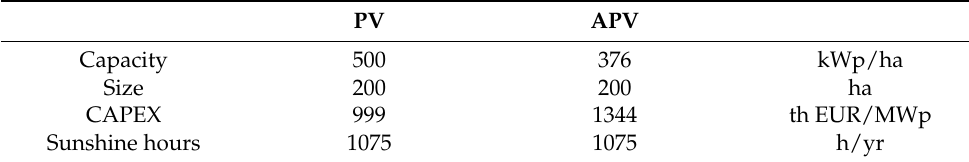
Table 4. Comparison of APV and ground-mounted PV.